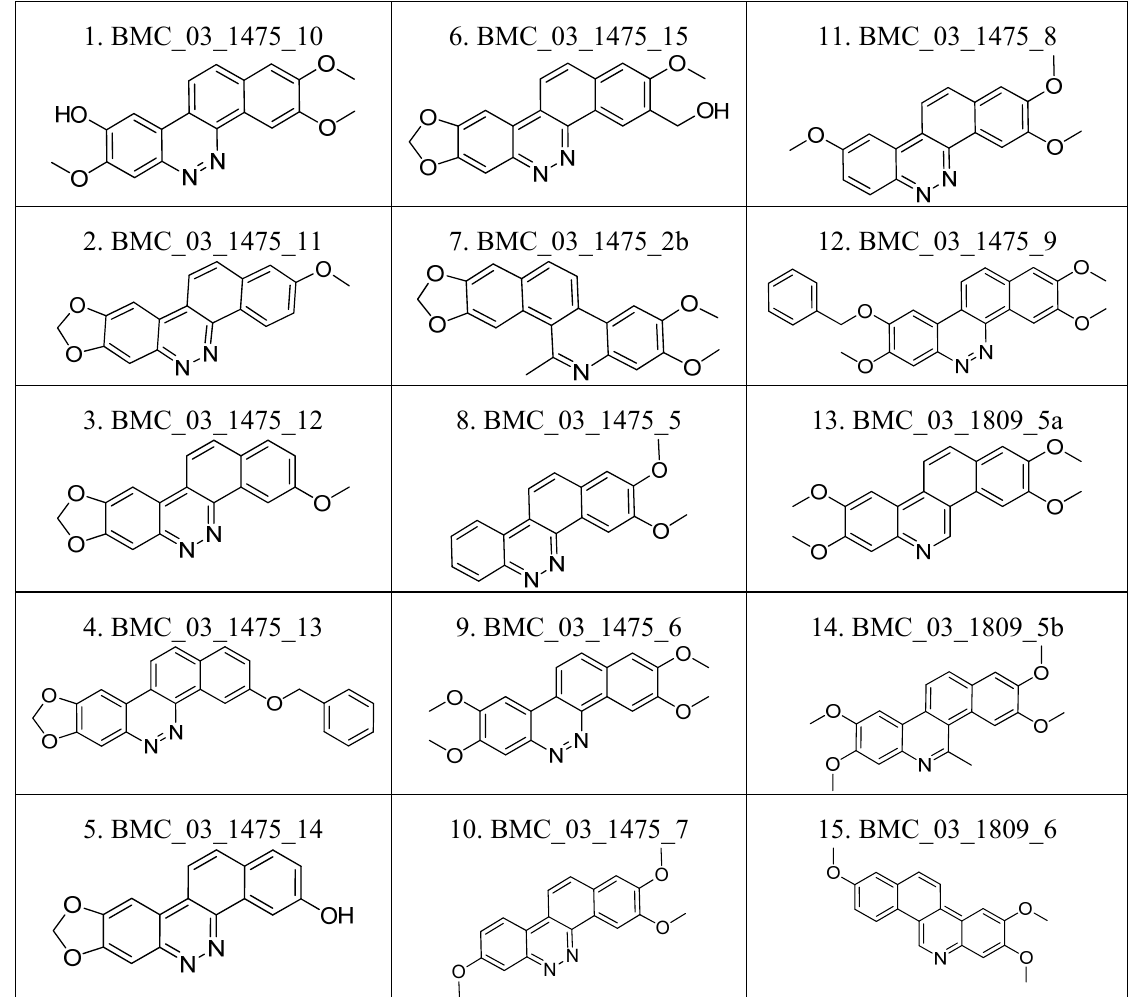
Table 6. Chemical structure of 137 benzo[ c ]phenanthridine